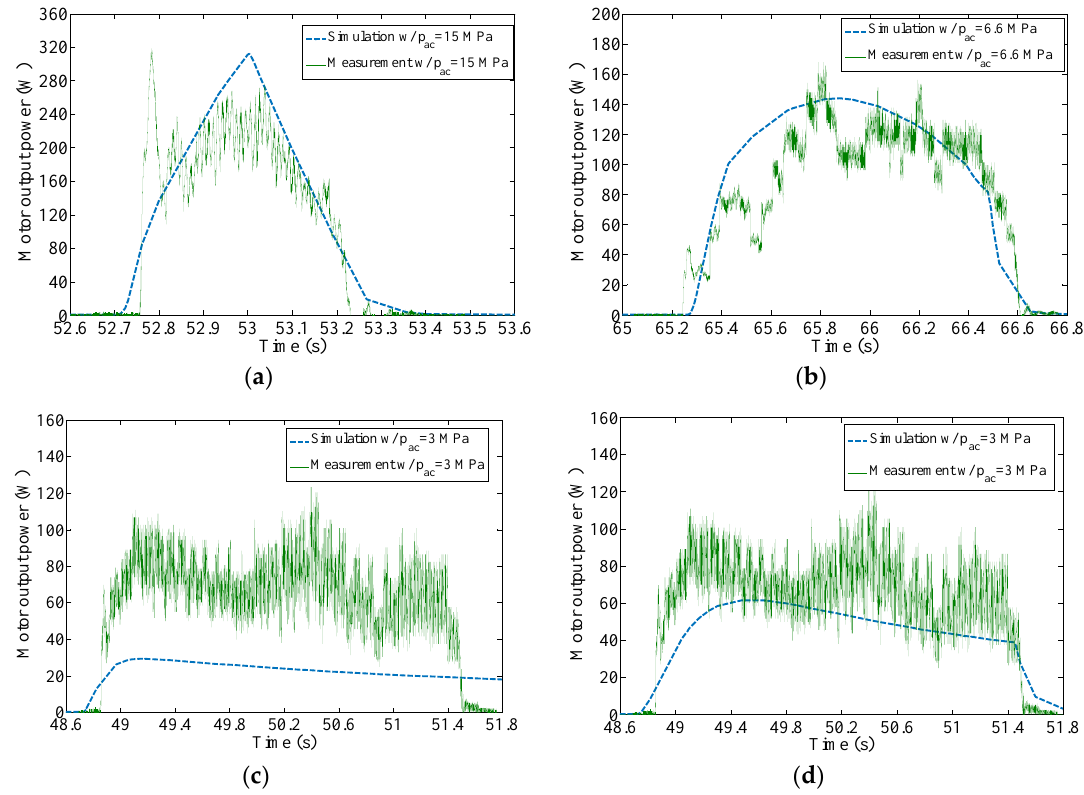
Figure 9. Simulated and experimental results on the hydraulic output power: ( a ) Accumulator pre-charged to 15 MPa and released at 21 MPa; ( b ) accumulator pre-charged to 6.6 MPa and released at 10 MPa; ( c ) accumulator pre-charged to 3 MPa and released at 4 MPa; and ( d ) accumulator pre-charged to 3 MPa and released at 4 MPa, but with an adjusted rotational damping coefficient from 0.50 Nm/(rad/s) to 0.20 Nm/(rad/s).